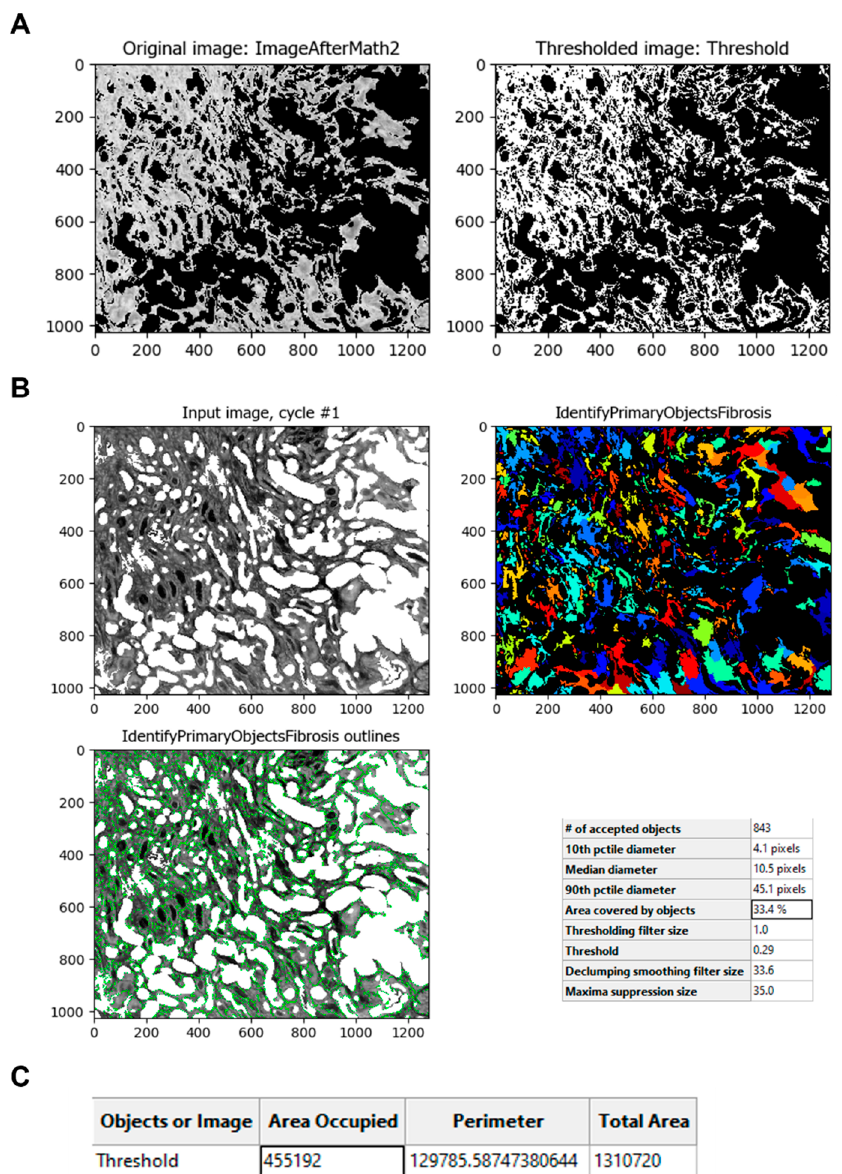
Figure 7. Fibrotic area identification and calculation. ( A ) The Threshold module calculates the thresh- old value to obtain the fibrotic area (white). ( B ) The IdentifyPrimaryObjects module identifies the fibrotic areas and gives a pre-value of the fibrotic percentage (boxed). ( C ) The MeasureImageAreaOccupied calculates the area of the fibrotic objects in the image (boxed). If the user wants to compare the fibrotic area identified by the pipeline with the orig- inal image, the module OverlayObjects merges both images, maintaining the objects col- ored (fibrotic area) for easy comparison between them (Figure 8).